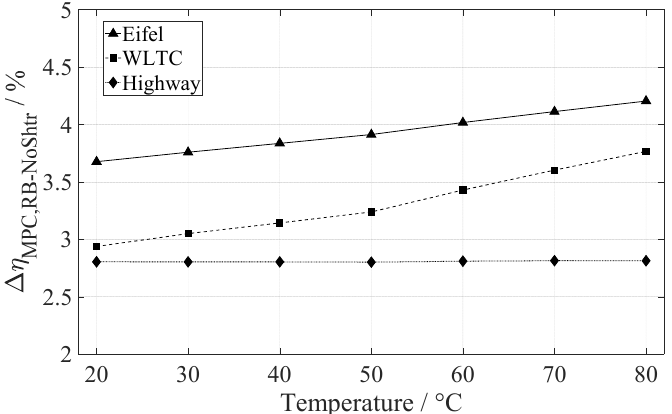
Figure 12. Overall efficiency increase for all three driving cycles using MPC in comparison to a rule-based strategy without shutter (RB-NoShtr) for component starting temperatures of 20–80 °C at 20 °C ambient temperature.